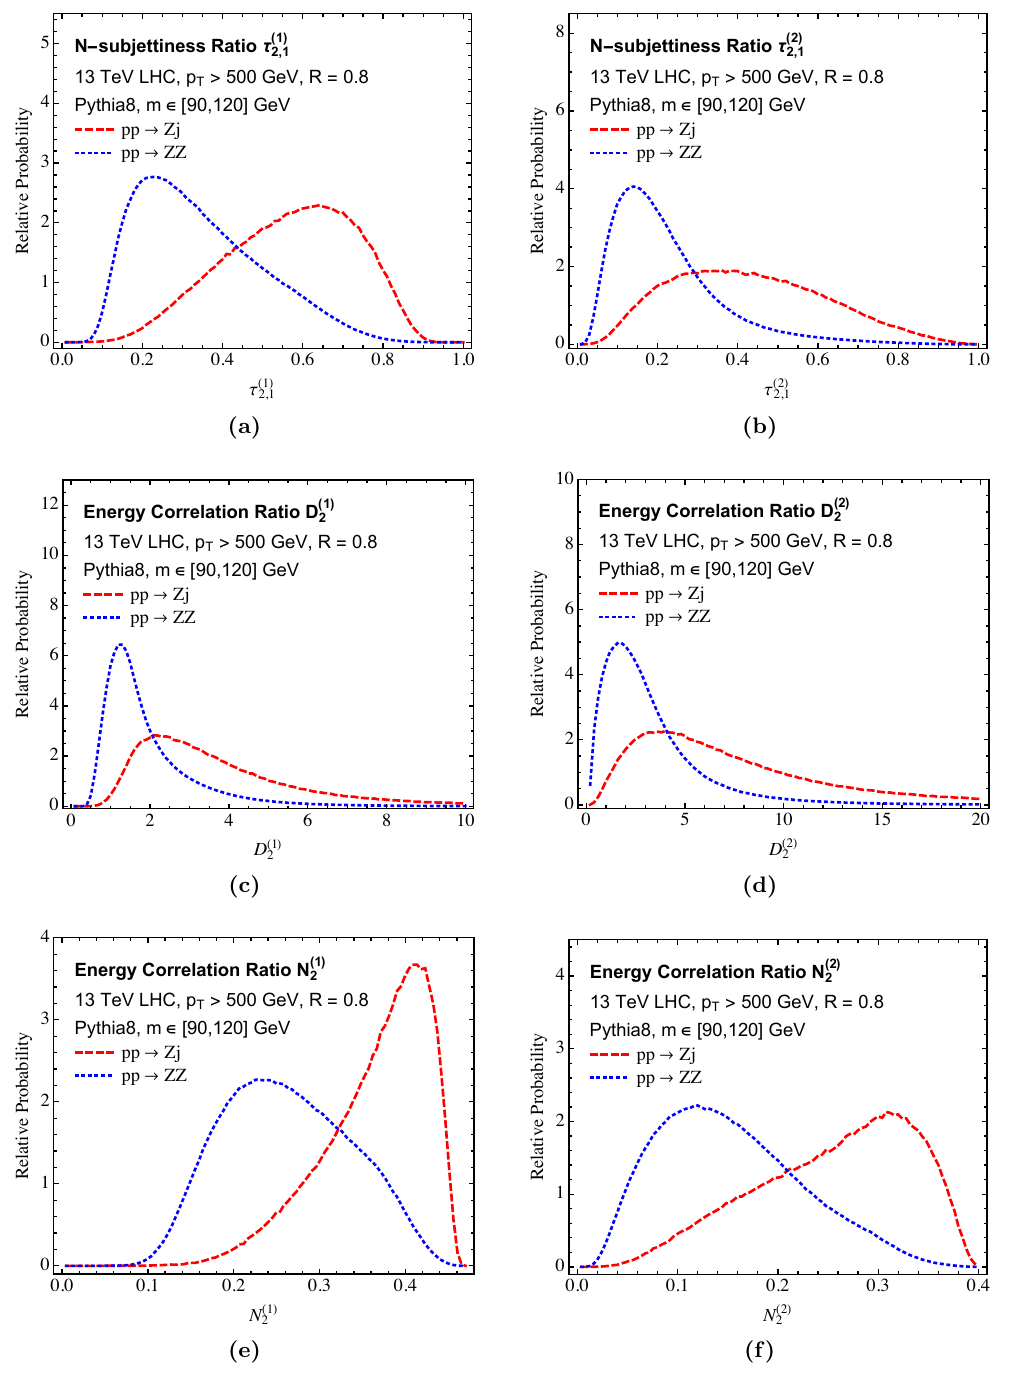
Figure 4. Distributions of various two-prong discrimination observables measured on the sample of jets showered with Pythia, on which a mass cut of m [90 ; 120] GeV has been placed. From 2 top to bottom are plotted signal (blue dotted) and background (red dashed) distributions of: N - subjettiness ratios (cid:28) (1) (left) and (cid:28) (2) (right), energy correlation function ratios D (1) (left) and 2 ; 1 2 ; 1 2 (right), and N (1) (left) and N (2) 2 2